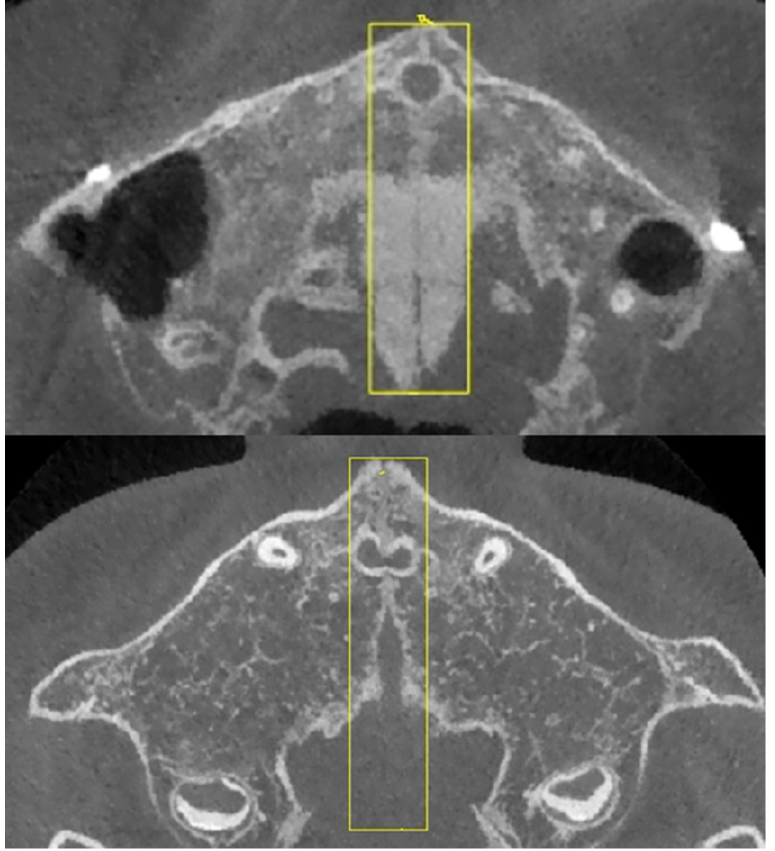
Figure 2. Labeling sample of the midpalatal suture region. The upper boundary of the CBCT axial sections is the upper margin of the palatal vault, the lower boundary is the apical point of the upper central incisors (choose the higher one when the two apical points are in different sections), the anterior boundary is the most anterior point of the midpalatal suture on the maxilla, and the posterior boundary is the most posterior point of the midpalatal suture on the palatine bone.